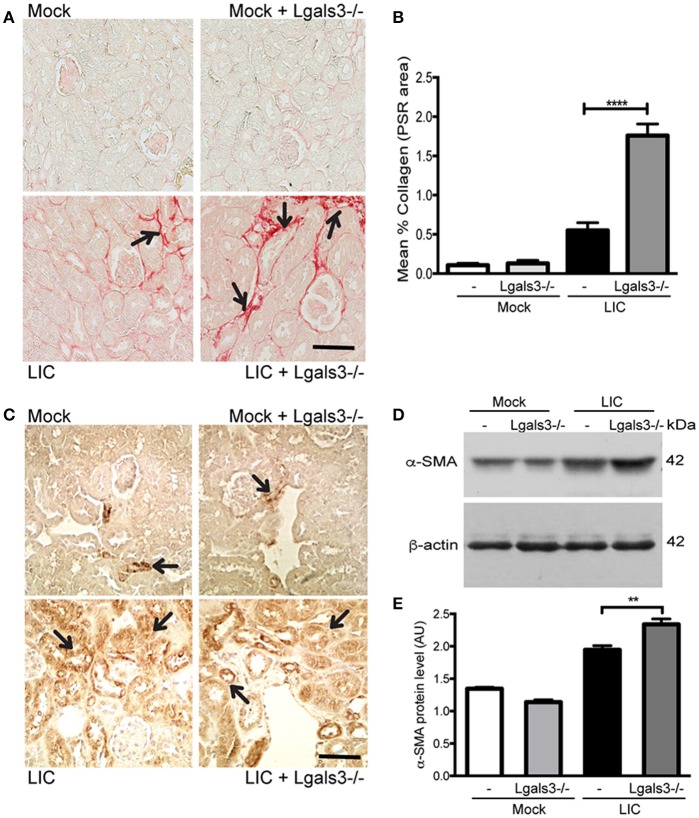
Genetic disruption of Gal-3 significantly increased the chronic fibrosis with similar chronic inflammation. (A,B) Picrosirius red was used for collagen staining of kidney sections for all groups of mice at 45 dpi and digital quantification of fibrosis revealed significantly increased collagen deposition in the LIC + Lgals3−/− group of mice at 45 dpi. (C–E) α-smooth muscle actin protein immunostaining in all groups of mice and representative western blot image of α-smooth muscle actin protein in kidney samples from LIC and LIC + Lgals3−/− groups of mice at 45 dpi; β-actin was used as a housekeeping control. Data represent assays of two independent experiments of groups of 6 animals, each. For digital quantification, the samples derive from the same experiment and the gels/blots were processed in parallel. AU, arbitrary units; **P < 0.01; ****P < 0.0001.